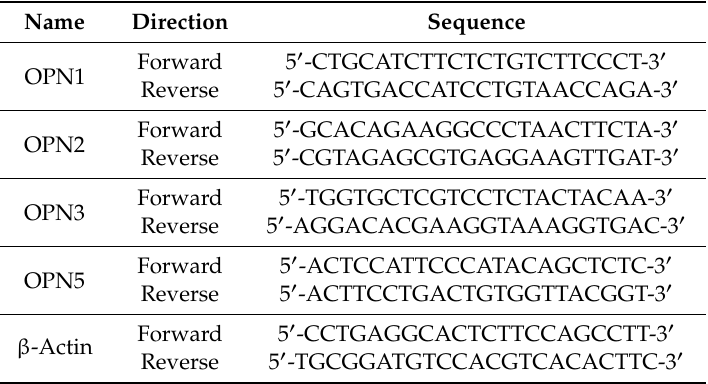
Table 2. Primer pairs for semi-quantitative